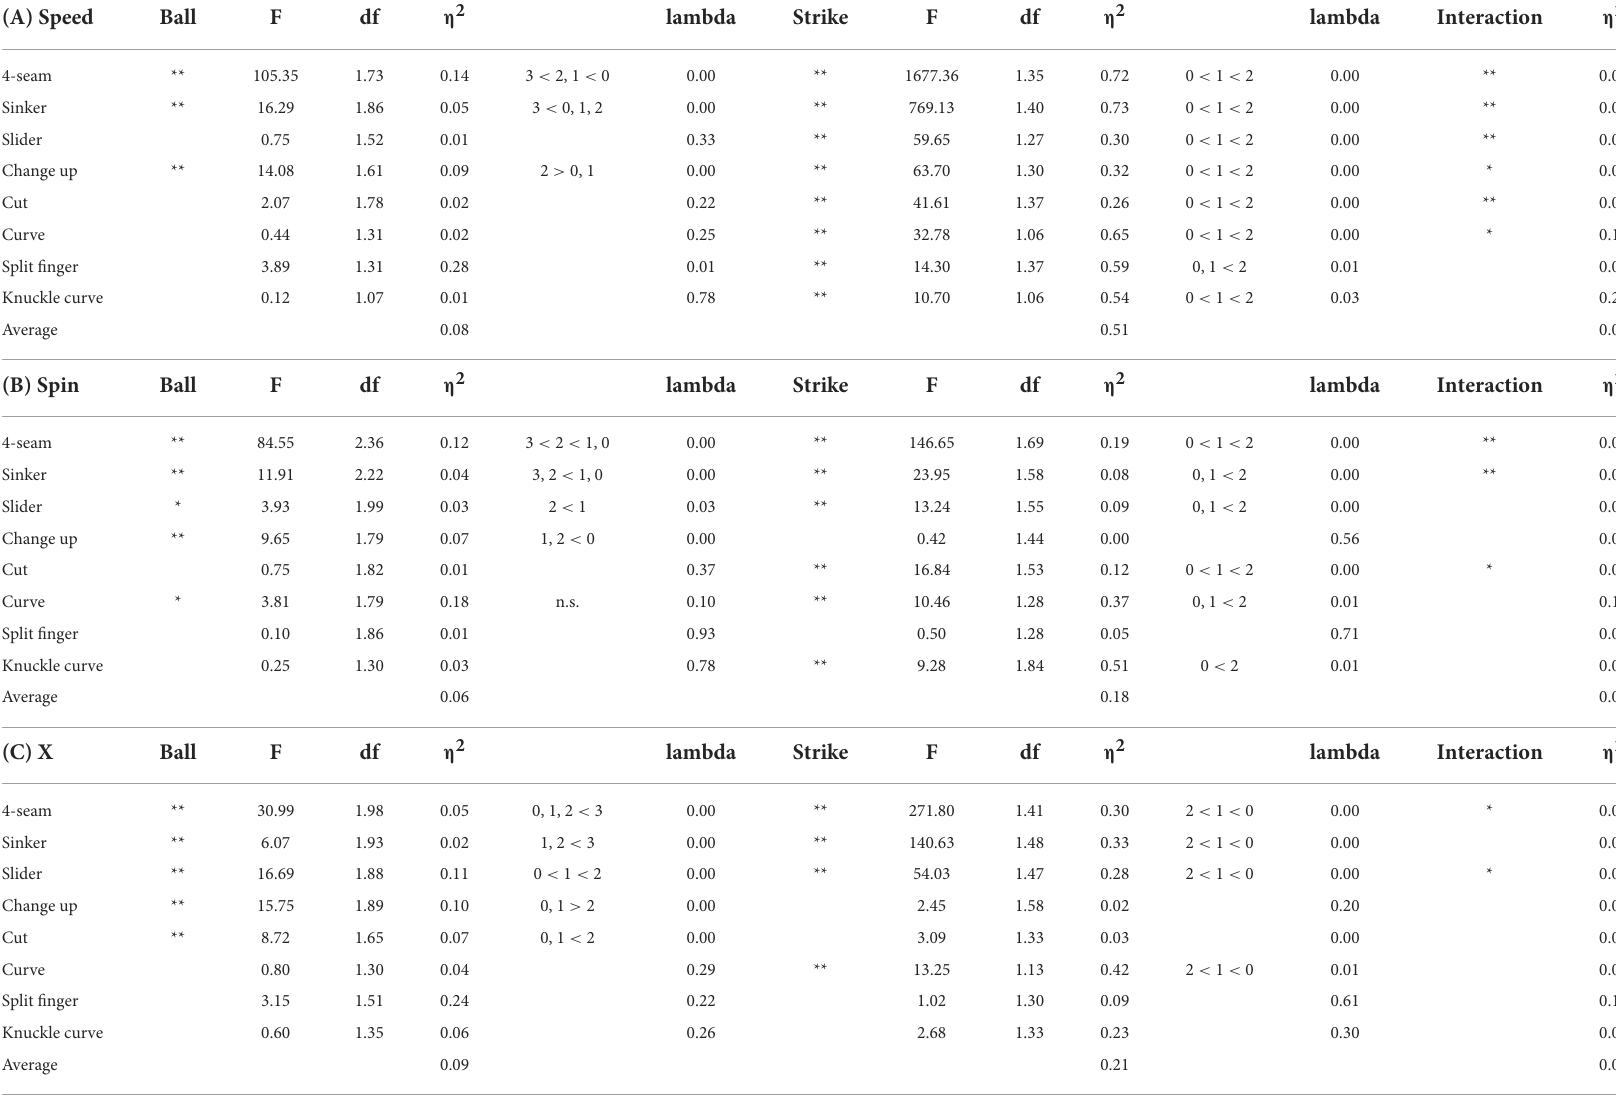
TABLE 3 Main effects of release speed, spin rate, 3D coordinate (X, Y, and Z axes) of the release point, and strike probability by ball and strike count in